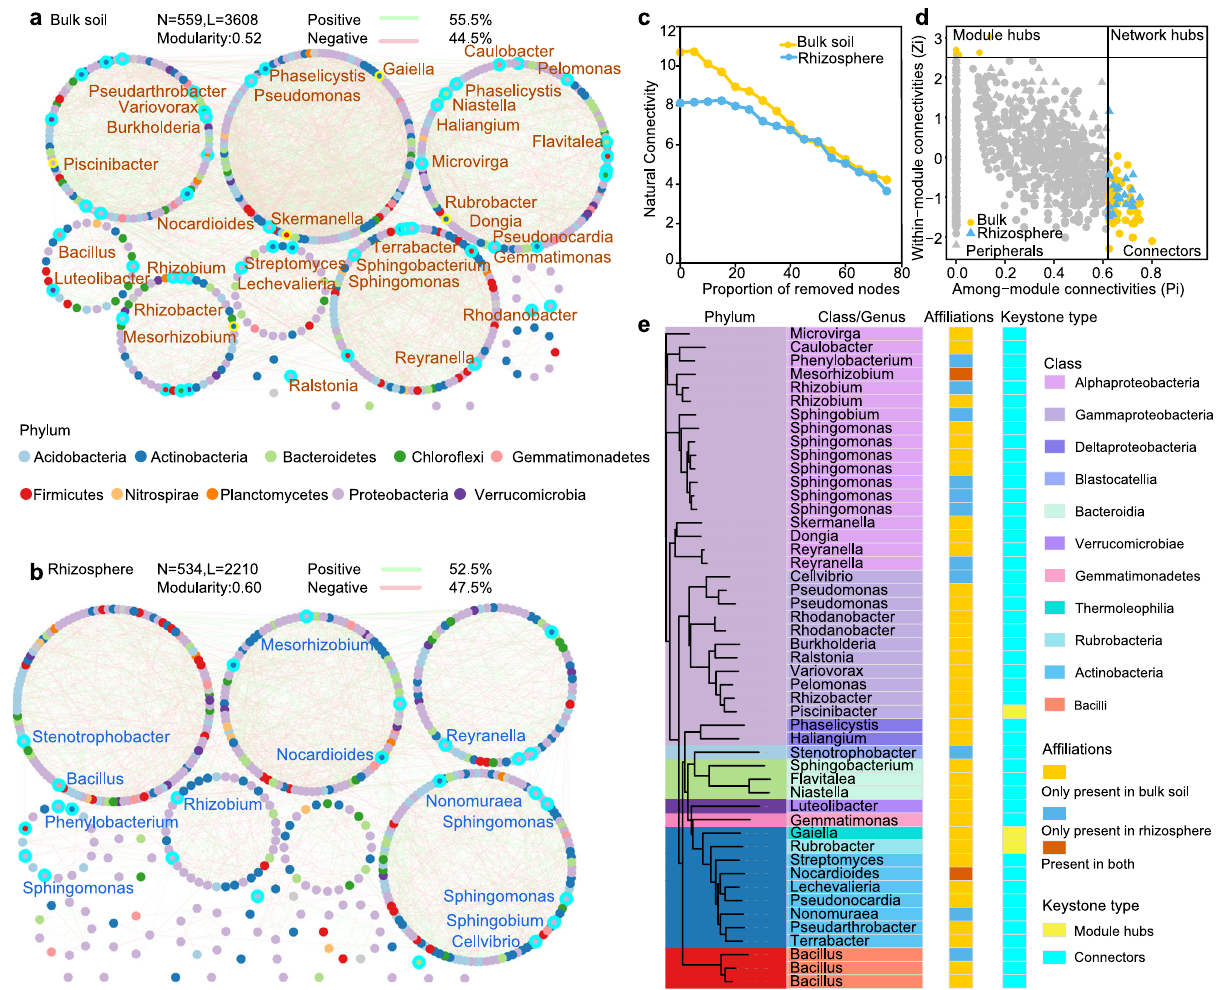
Fig. 3 Global co-occurrence networks of bacterial amplicon sequence variants (ASVs) in the rhizosphere and in bulk soil. a a co-occurrence in the global bulk soil; b , a co-occurrence in the global rhizosphere. Colors of nodes indicate the different major phyla. c Robustness of global bacterial networks in bulk soil (yellow dots) and the rhizosphere (blue dots) (bulk soils n = 1759 vs. rhizosphere n = 2182); d classi fi cation of nodes to identify the keystone ASVs in the networks. e Phylogenetic tree of keystone ASVs in the networks. The taxonomy of keystone ASVs is also labeled at the genus level in yellow in the global bulk soil network ( a ) and in blue in the global rhizosphere network ( b ). Source data are provided as a Source data fi